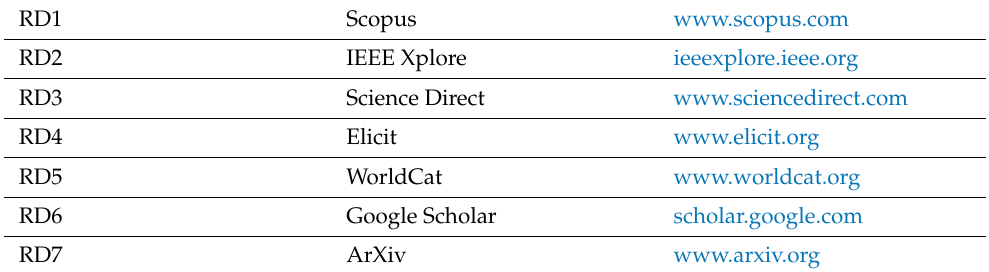
Table 2. Research Databases.